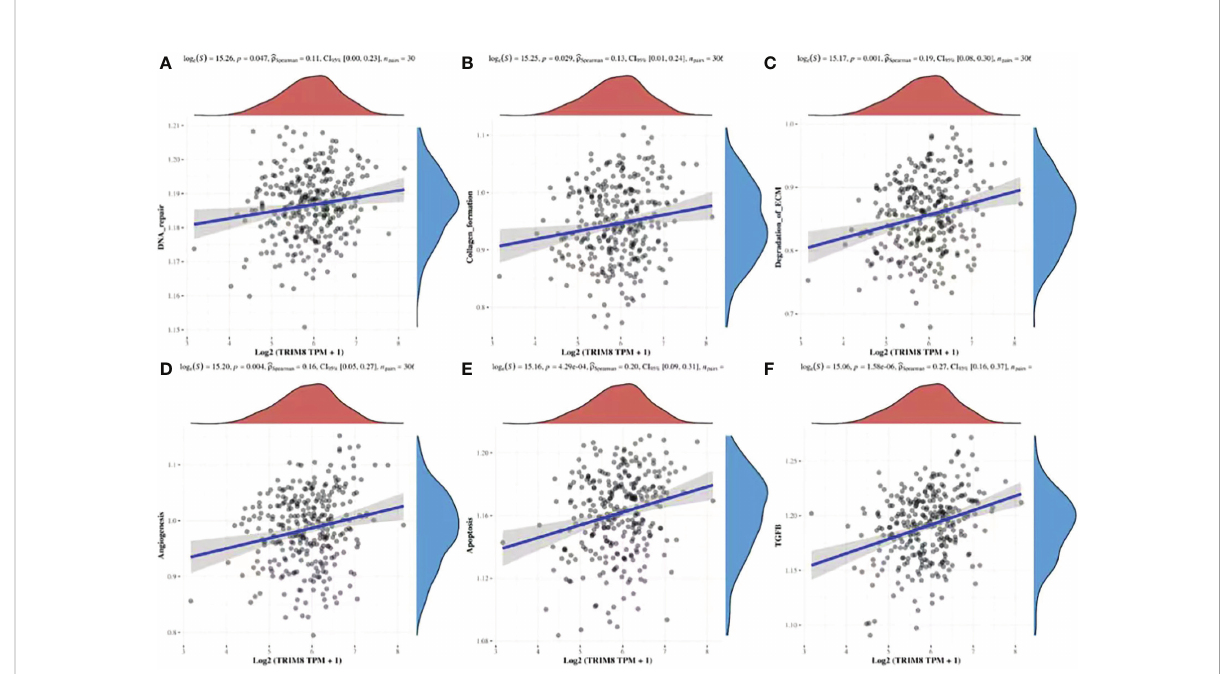
FIGURE 9 Spearman correlation analysis between TRIM8 and pathway score. (A – F) The signal pathway positively correlated with the high expression of TRIM8 was